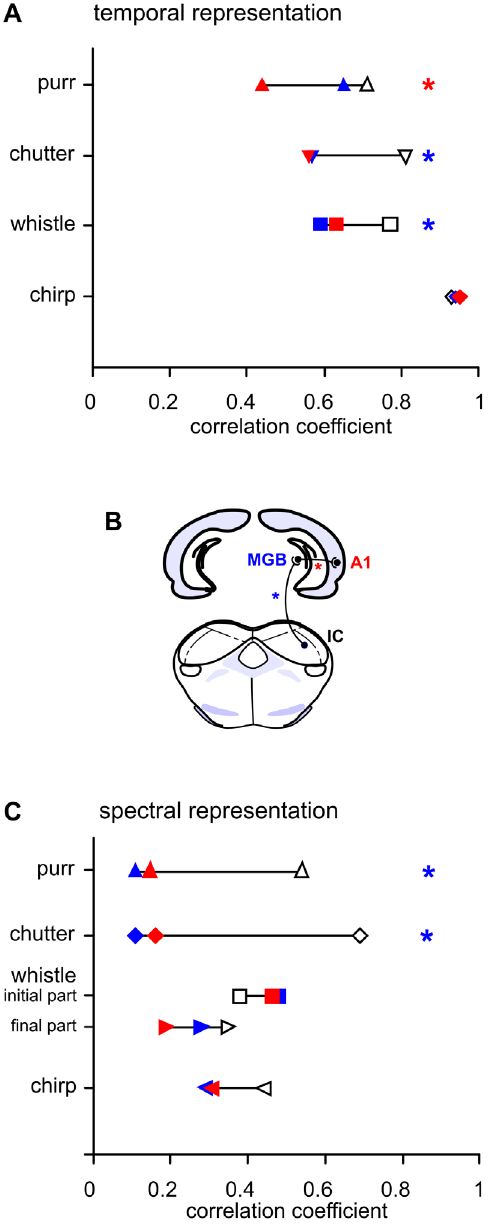
Figure 7. Comparison of subcortical nuclei (IC, MGB) and the auditory cortex. The correlation coefficients between the sound envelope and the averaged PSTH (A) and the correlation coefficients between the sound frequency spectrum and rate vs. CF profile (C) are compared in the inferior colliculus (IC, open), medial geniculate body (MGB, blue) and auditory cortex (AI, red) for individual call. Panel (B) shows a schematic drawing of a part of the ascending auditory pathway. IC data based on 153 neurons are taken from [2]; MGB data calculated from 209 neurons are taken from [18]. The bootstrap method was used to determine whether the values of the correlation coefficients in individual nuclei were statistically different (P , 0.01). The blue stars indicate cases of tecto-thalamic transformation of the neuronal response in which the IC data were significantly different from the MGB and AI data, while the difference between the MGB and AI was not significant. The red star indicates a case of thalamo-cortical transformation of the neuronal response in which the AI data were significantly different from MGB and IC data, while the difference between the MGB and IC was not